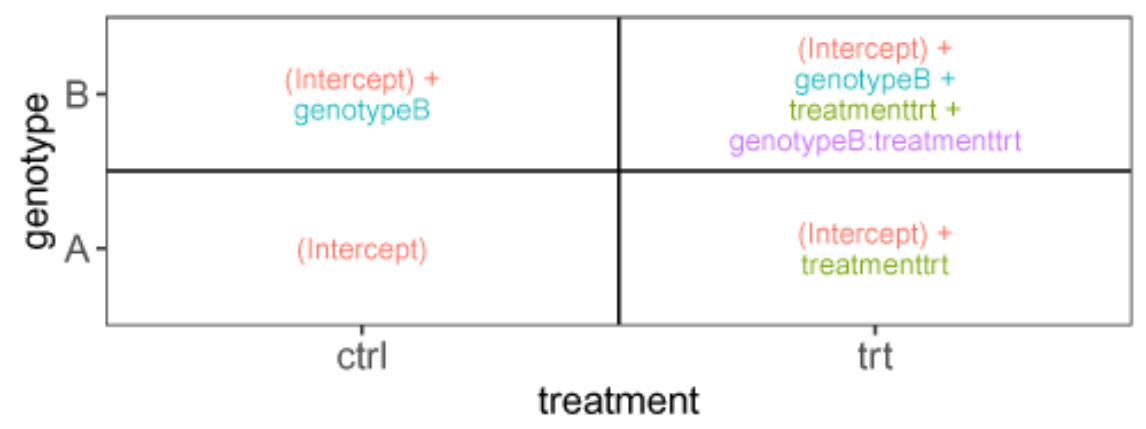
Figure 2. Values of the linear predictor, in terms of the model parameters, for the two-factor example design, with and without an interaction